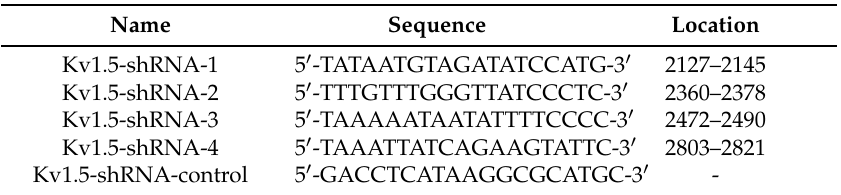
Table 1. siRNA targeting